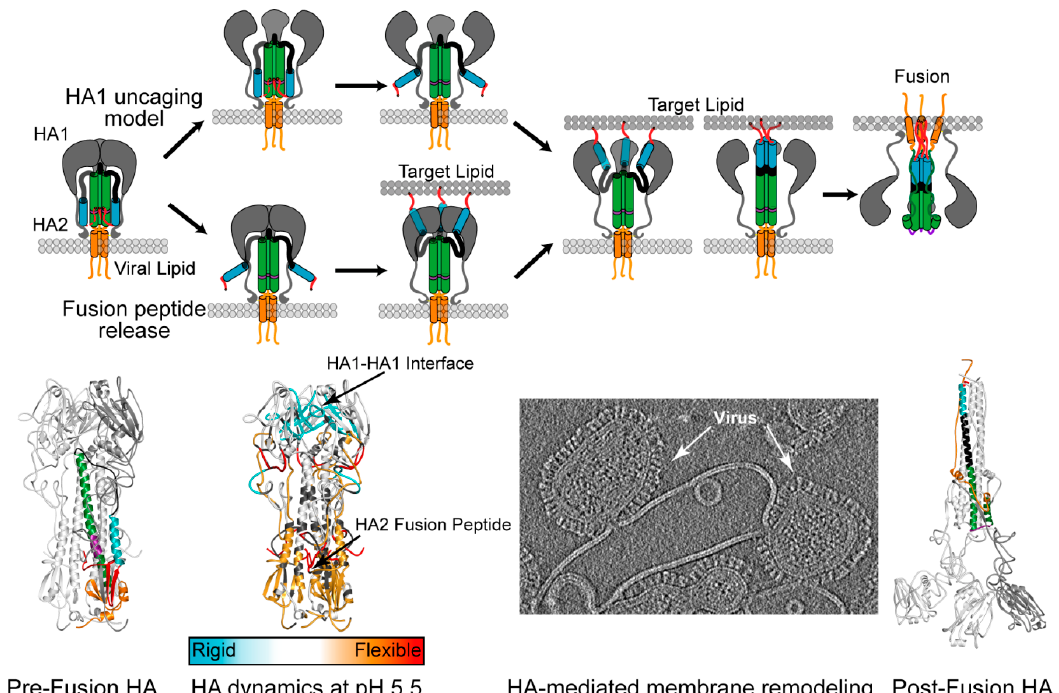
Figure 3. Influenza Hemagglutinin pH-Activation Models. Pre-fusion HA is composed of the two subunits, HA1 ( grey ) and HA2 fusion domain with the fusion peptide and proximal regions ( red ), the short helix ( blue ), the B-loop ( black ), the long helix ( green and purple ), and the C-terminal regions ( orange ), colored identically on 3HMG crystal structure below. The pH-dependent membrane fusion is hypothesized to commence either by the uncaging of HA1 ( top pathway ) from the HA2 fusion machinery, or by the release of the fusion peptide from the core of the trimer ( bottom pathway ). Once the fusion peptide is released, it binds the target membrane and the subsequent refolding of the B-loop and long helix ( purple ), drives the fusion of the viral membrane with the target membrane. Membrane fusion ends in the post-fusion conformation depicted in the bottom panel where HA1 lobes are modeled onto the 1QU1 crystal structure. Recent solution-based techniques such as HDX-MS and cryo-electron tomography have provided evidence for the fusion peptide release model for H3 HA isolate fusion activation. The HDX dynamic changes are illustrated as regions more flexible at low pH ( red ) colors and more ordered regions at low pH ( blue ). In the cryo-electron tomogram, acid-activated influenza virus is shown at early stages of membrane fusion with a synthetic